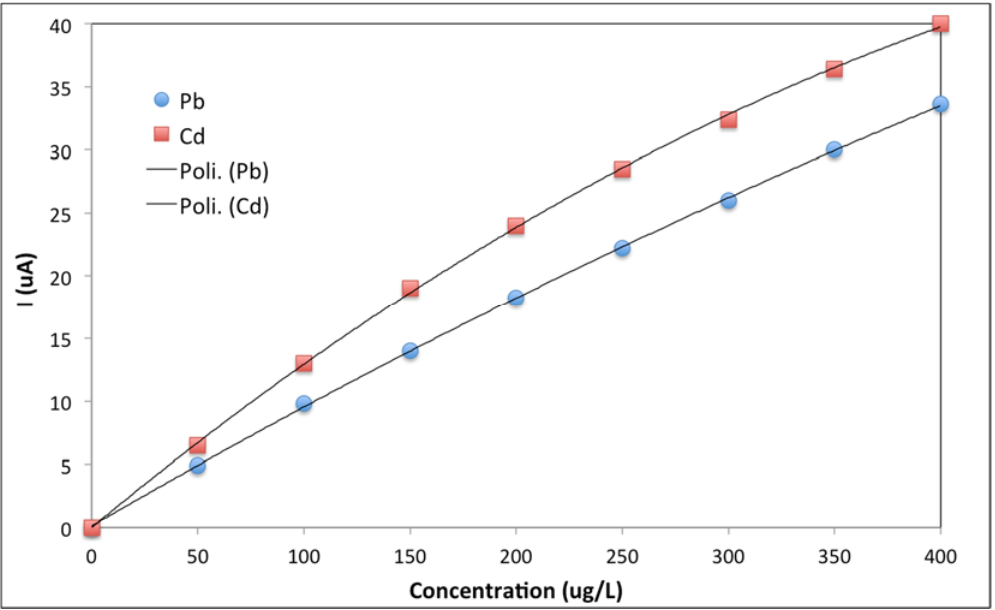
Figure 9. Calibration curves in flow injection analysis stripping voltammetry for Pb and Cd between 0 and 400 µ g/L. Discrete points: experimental data; black lines: second-order polynomial interpolating curves.